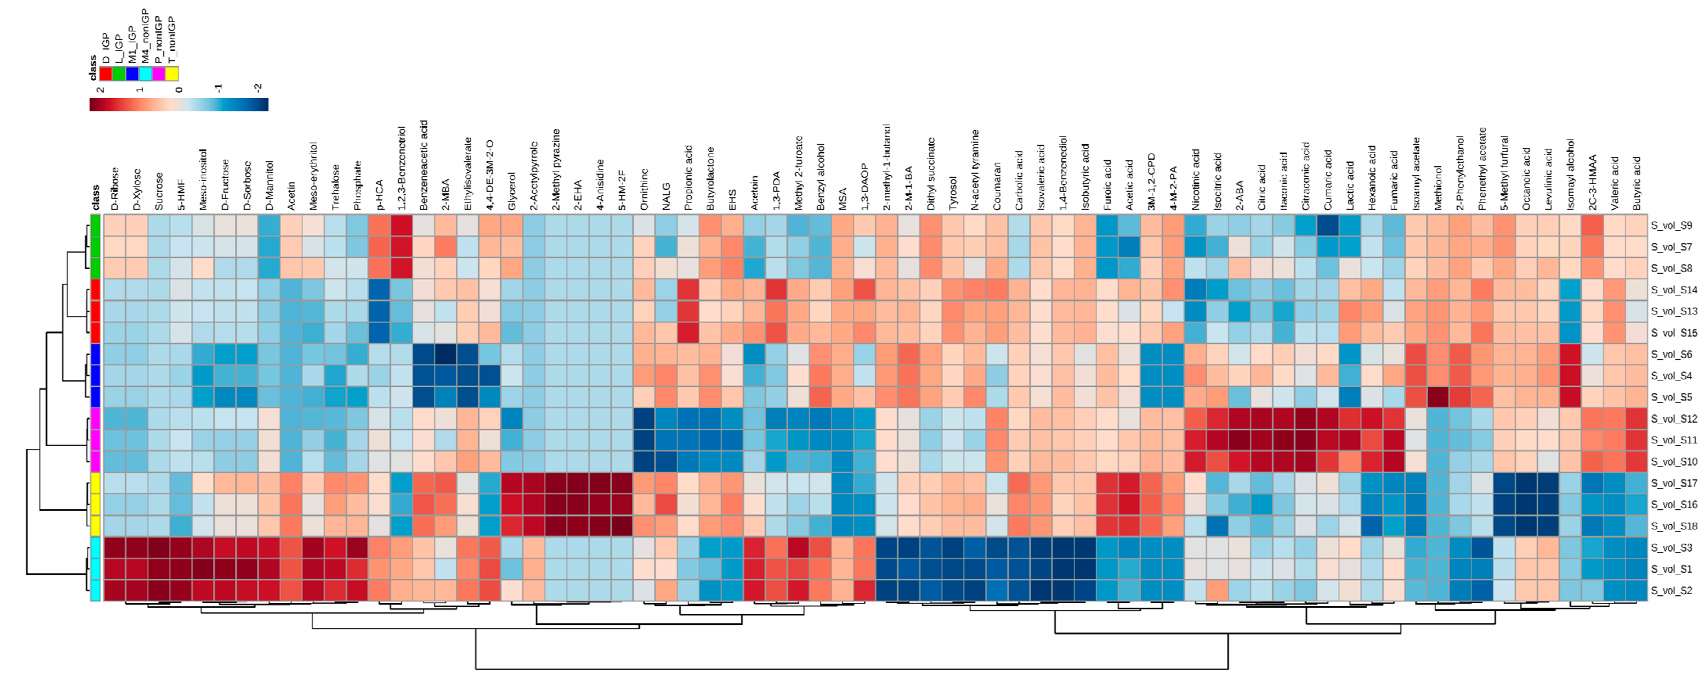
Figure 1. Hierarchical cluster analysis performed using metabolite profiles of balsamic vinegars. The heatmap was generated using 70 most significant metabolites ( p -value < 0.05) by a Ward algorithm and Euclidean distance analysis. IGP denotes the samples certified as Protected Geographic Indication to indicate their premium quality, while non-IGP samples are regular commercial vinegar samples. Here, D = Delmaine TM , L = Lupi TM , M1 = Mazetti TM one leaf, M4 = Mazetti TM four leaves, P = Pam’s TM and T = Tastemaker TM , 5-HMF = 5-Hydroxymethylfurfural, p -HCA = p -hydroxycinnamic acid, 2-MBA = 2-methylbutyric acid, 4,4-DE-3M-2-O = 4,4-Diethyl-3-methylene-2-oxetanone, 2-EHA = 2-Ethylhexanoic acid, 5-HM-2-F = 5-Hydroxymethyl-2-furaldehyde, NALG = N -Acetyl-glutamate, EHS = Ethylhydrogen succinate, 1,3-PDA = 1.3-Propylene diacetate, MSA=Methylsuccinic anhydride, 1,3-DAOP = 1,3-Diacetoxypropane, 2-M-1-BA = 2-Methyl-1-butyl acetate, 3-M-1,2-CPD = 3-Methyl-1,2-cyclopentanedione, 4-M-2-PDA = 4-Methyl-2-pentanoic acid, 2-ABA = 2-Aminobutyric acid.